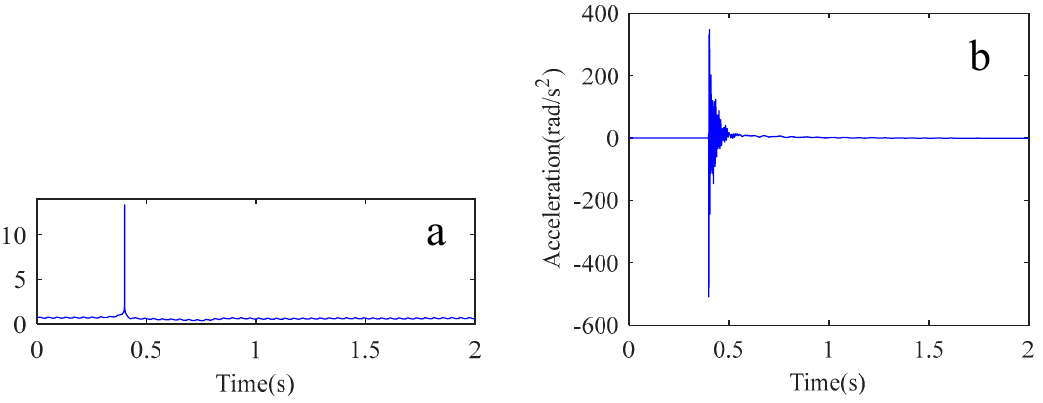
Figure 17. The results of the impact experiment. ( a ) impact torque signal; ( b ) vibration acceleration signal.